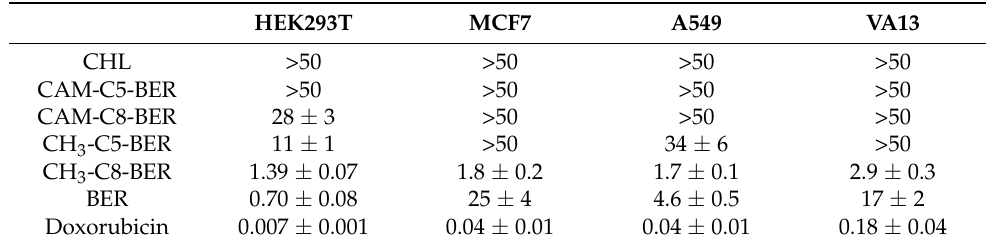
Table 3. Growth inhibition by CAM-Cn-BER in relation to a number of cell lines according to the MTT assay. Values of a half-maximal inhibitory concentration (IC50, µ M) are